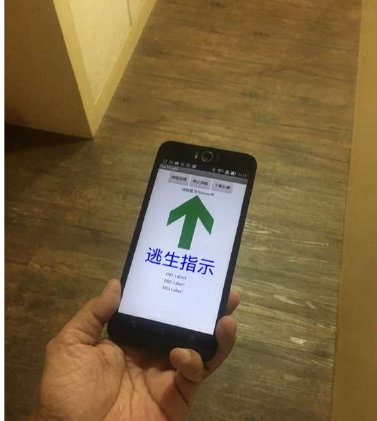
Figure 3. Smartphone app user interface showing the safest evacuation route. (Chinese in this fig- ure means Escape instructions)